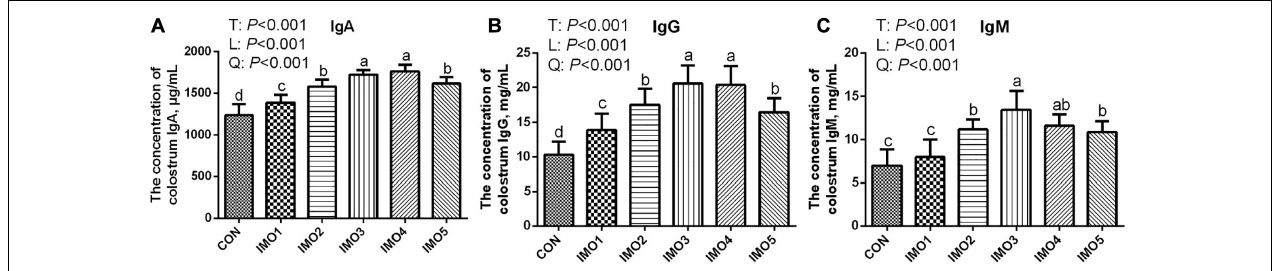
FIGURE 2 | Effects of dietary isomaltooligosaccharide (IMO) levels on the concentrations of colostrum IgA (A) , IgG (B) , and IgM (C) . Data are presented as means ± SD ( n = 7). (a–d) Significant effects of treatment ( P < 0.05; values with different lowercase letters are significantly different; T, total; L, linear; Q, quadratic).